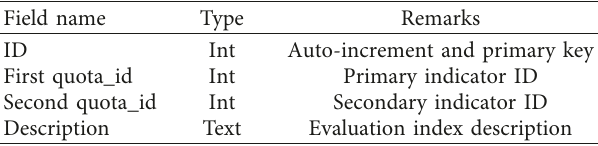
Table 6: Evaluation index of course performance.